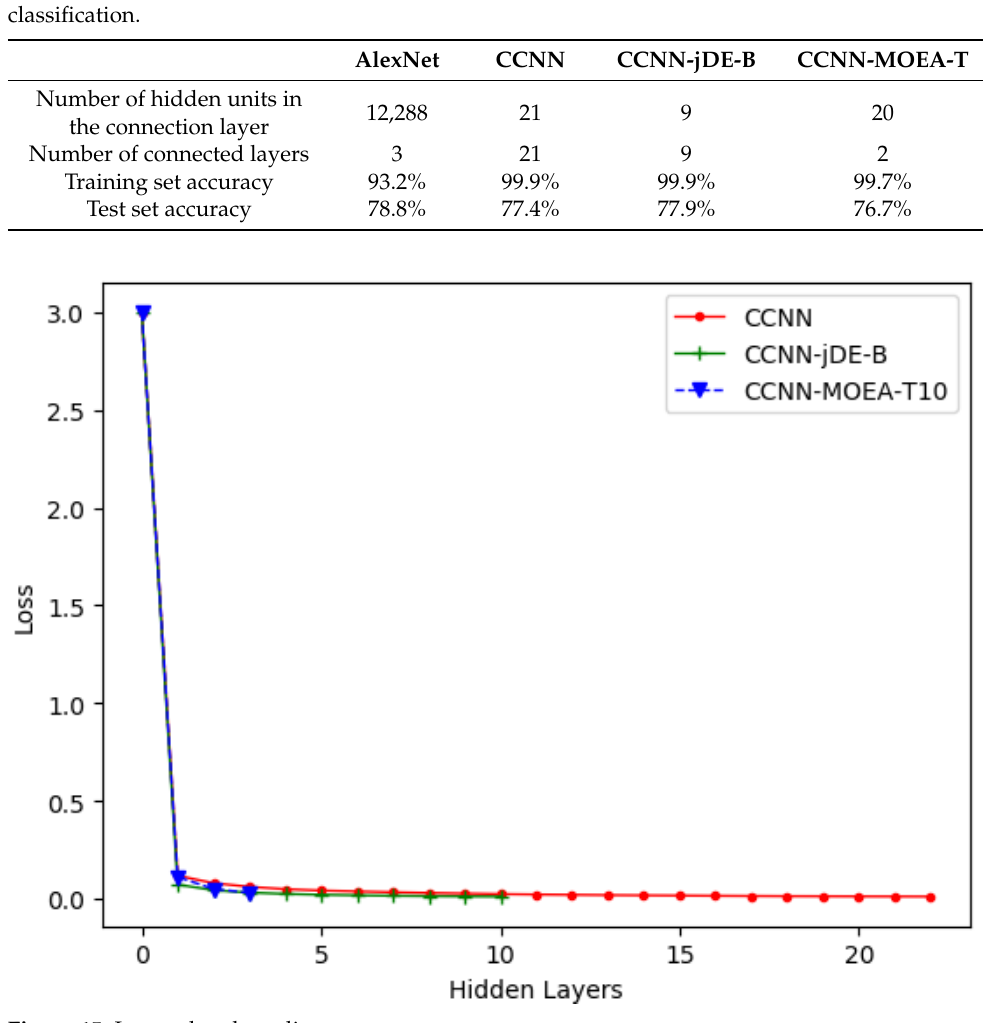
Figure 15. Loss value drop diagram.